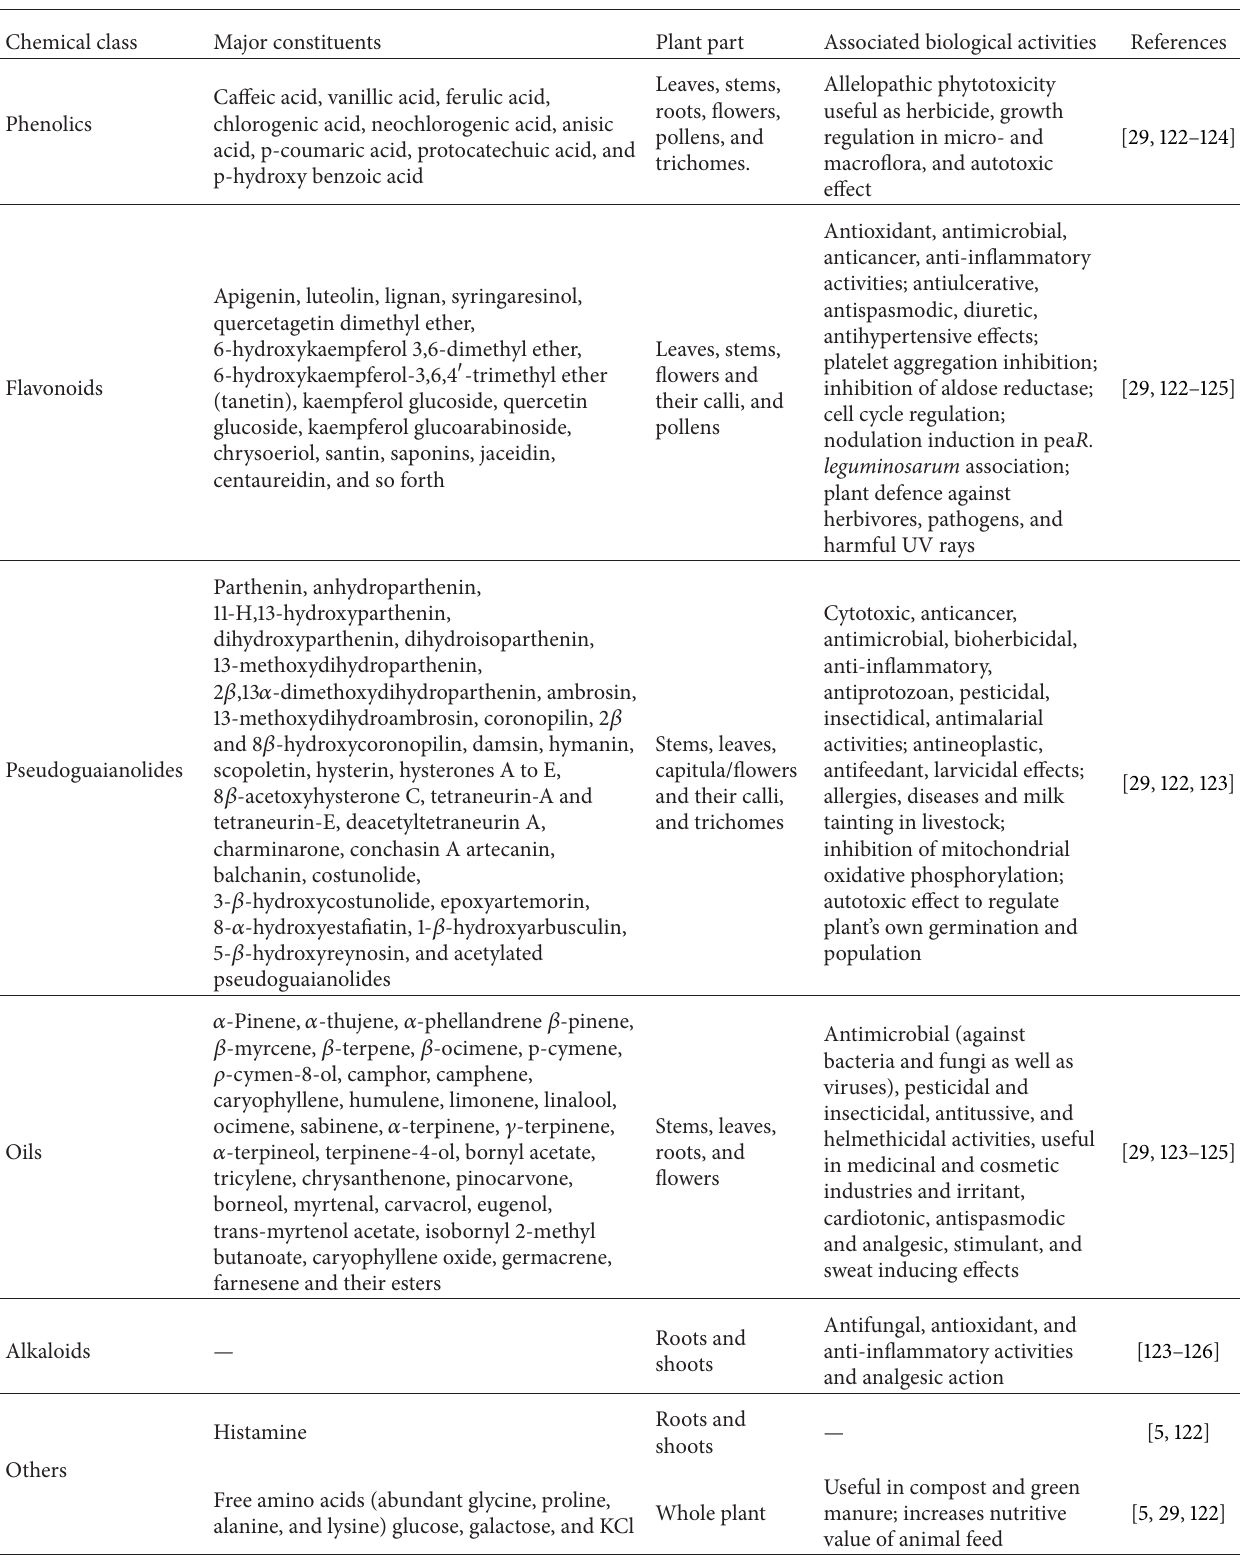
Table 1: Phytochemical constituents of Parthenium hysterophorus